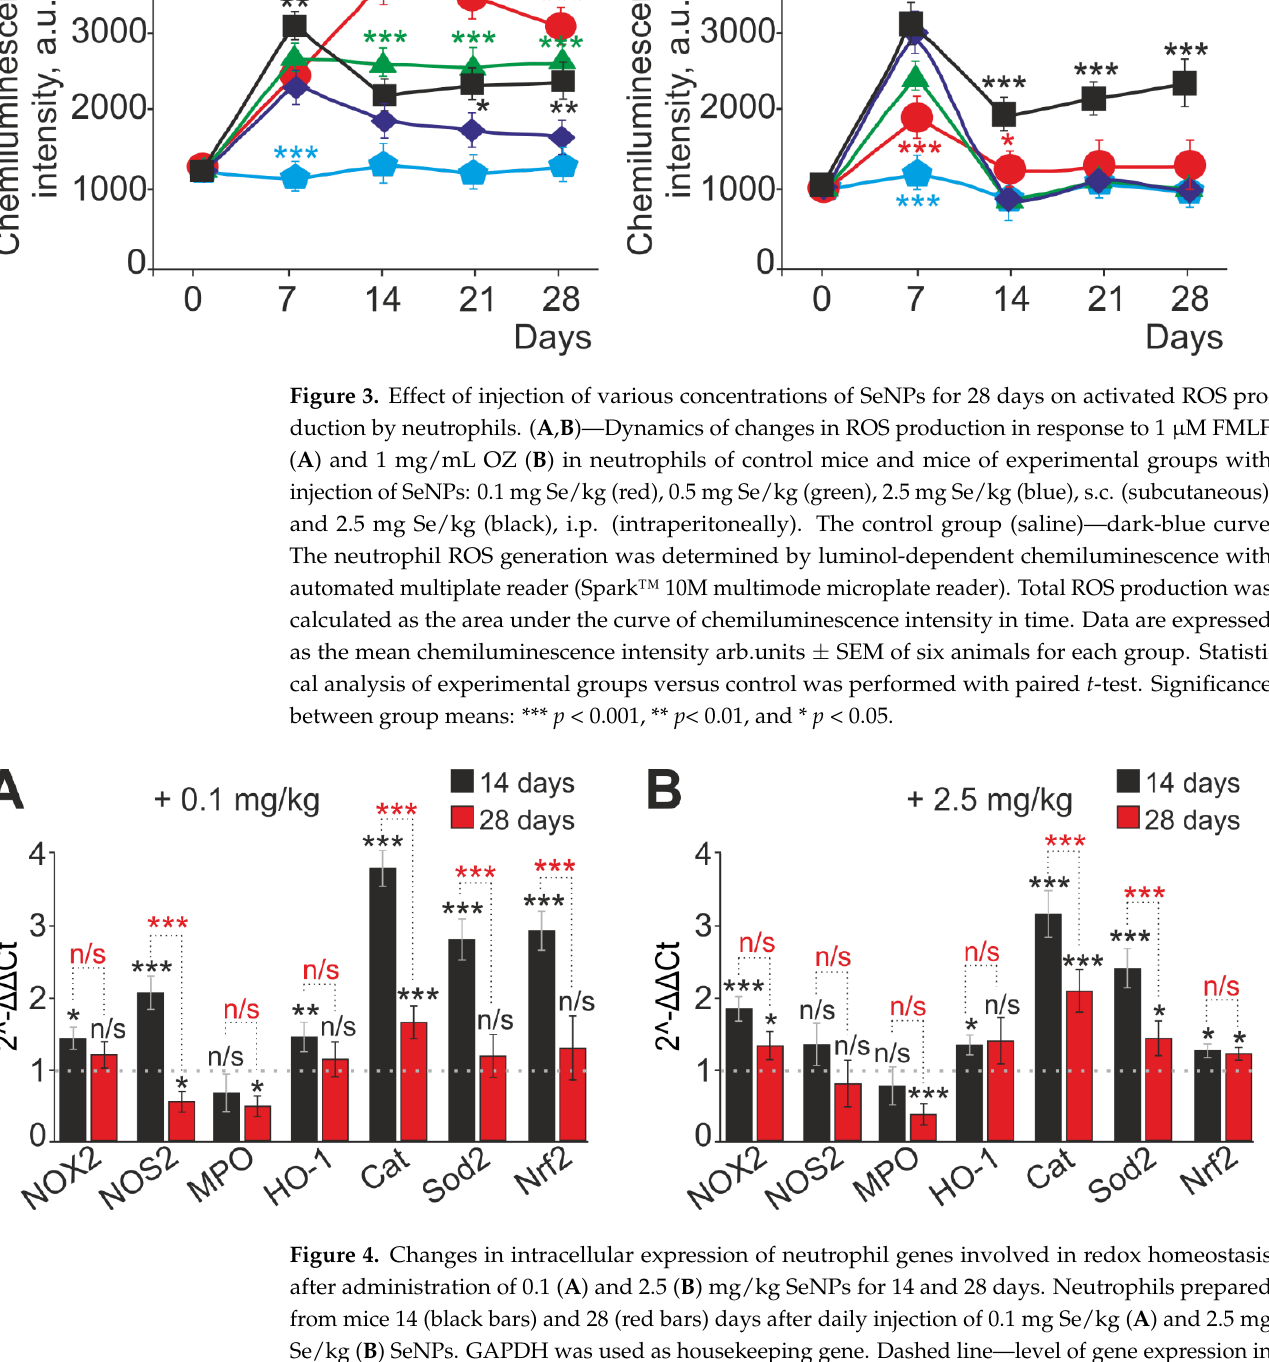
trophils, and the maximum effects were manifested at a low concentration of SeNPs (0.1 mg/kg). 2.3. The Action of SeNP Injections into Mice Regulates the Inflammatory Status of Neutrophils The functional state of neutrophils upon administration of SeNPs to mice, in addi- tion to the Red/Ox status, can also be characterized by changes in the inflammatory status of cells. Administration of 0.1 and 2.5 mg/kg SeNPs to mice for 14 days resulted in a sig- nificant increase in the expression of mRNA of inflammatory factors TNFa, IL1b, IL6, NF-kB, and SOCS3 (Figure 5A,B), whereas a longer application of the used concentra- tions of SeNPs (28 days) led to a decrease in the expression of the listed genes (Figure 5). The SeNP concentration injected into the experimental animals impacted the expression of the anti-inflammatory cytokine IL10. For instance, at a low concentration of SeNPs (0.1 mg/kg), expression growth was observed (Figure 5A). On the contrary, at a high concen- tration of SeNPs (2.5 mg/kg)m suppression was observed (Figure 5B). On the 28th day of SeNP administration, IL10 expression was inhibited in both experimental groups (Figure 5A,B).